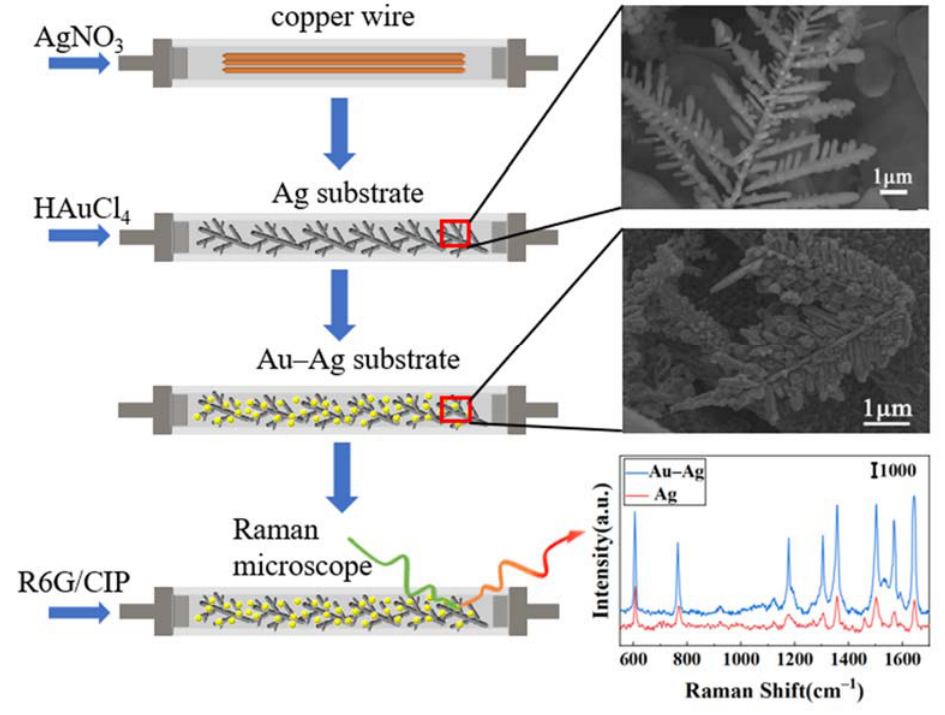
Figure 1. Schematic diagram of capillary ‐ based 3D dendritic Au–Ag substrate.